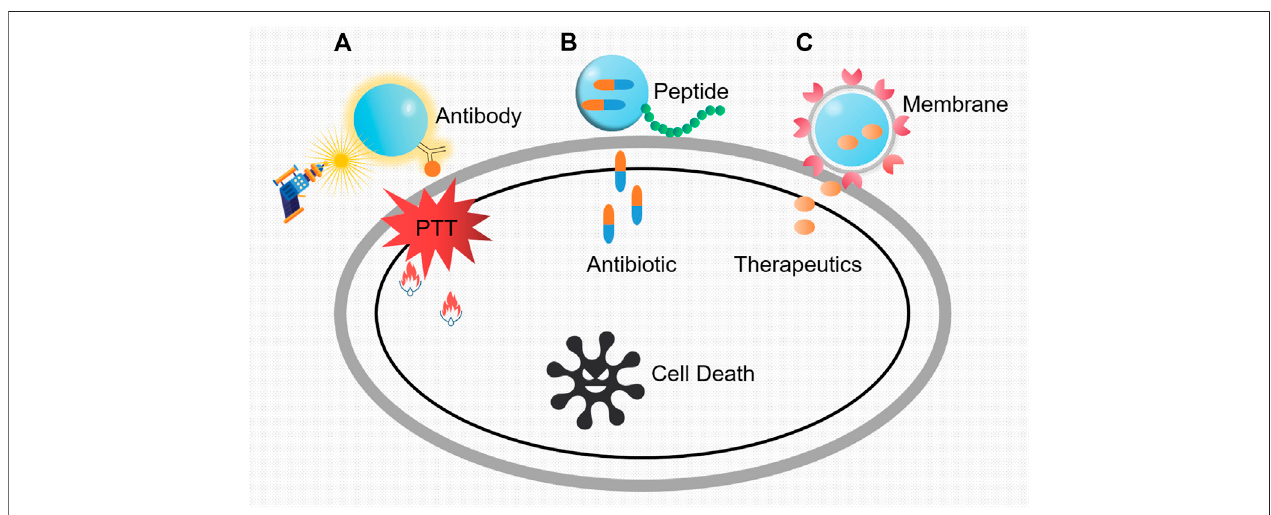
FIGURE3| Threemainmodesofnanoparticlesaspotentvehiclestotargetpathogens. (A) Killingmechanismsofnanoparticlesloadedwithantibodyspeci fi ctothe pathogenic bacteria. The constant exposure of laser irradiation was transformed into heat, which leads to the regional cell damage and the inevitable cell death. PTT referstophotothermaltherapy. (B) Antibiotic-loaded nanoparticleswithtargeted peptides. Aftertheidenti fi cation ofthespeci fi cbacterialregion,theshellbreaksandthe inside antibiotic releases. (C) The action modes of nanoparticles coated with vesicles from platelet membrane. Owing to the pretreatment with speci fi c bacteria, markers on vesicle membranes will conduct recognition, and the target bacteria will be killed by the subsequent release of the therapeutics.